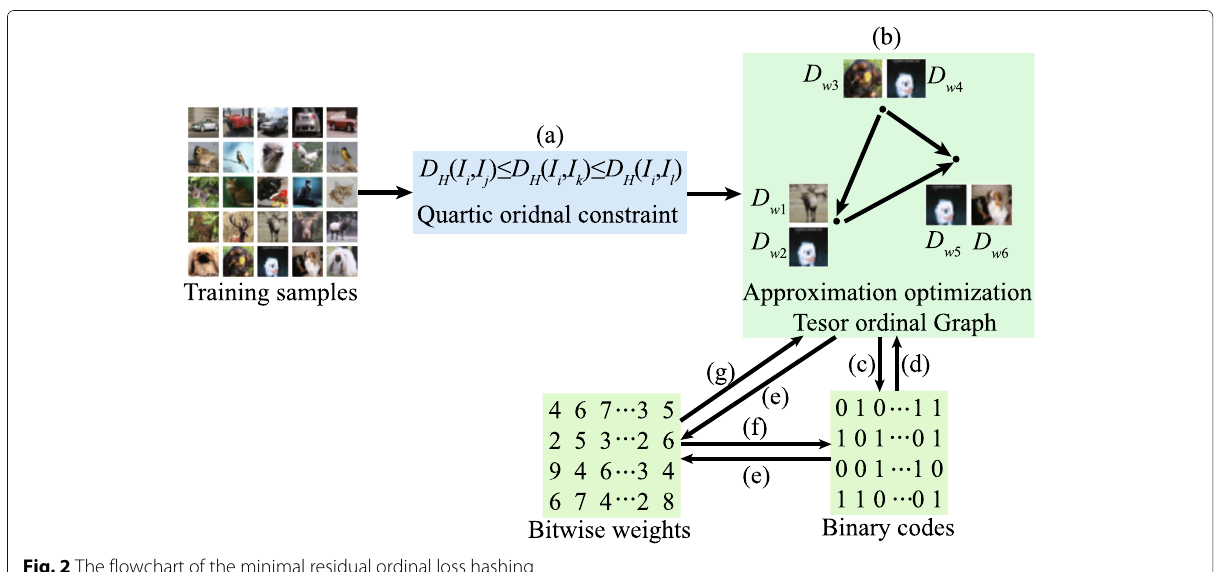
Fig. 2 The flowchart of the minimal residual ordinal loss hashing